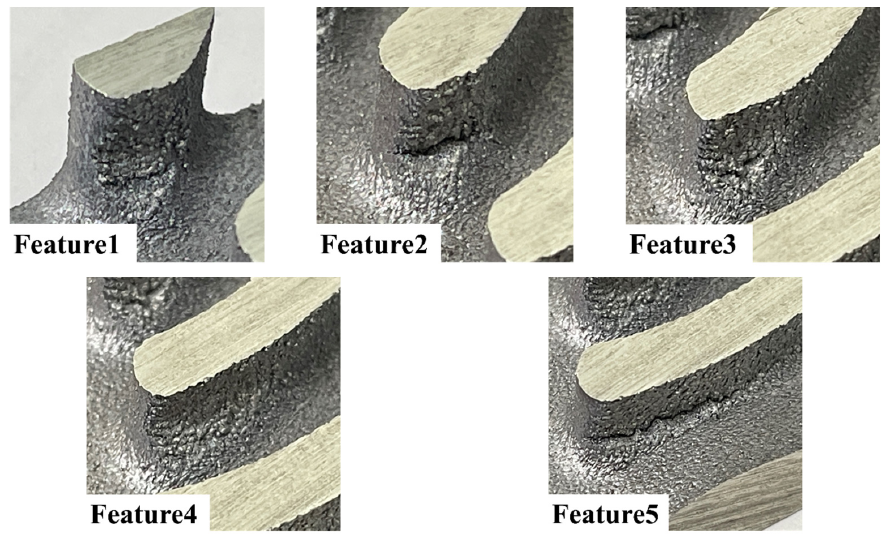
Figure 26. Contours of orientation angle and re-evaluated orientation angle yielded by the proposed algorithm over the surface of sample 3.